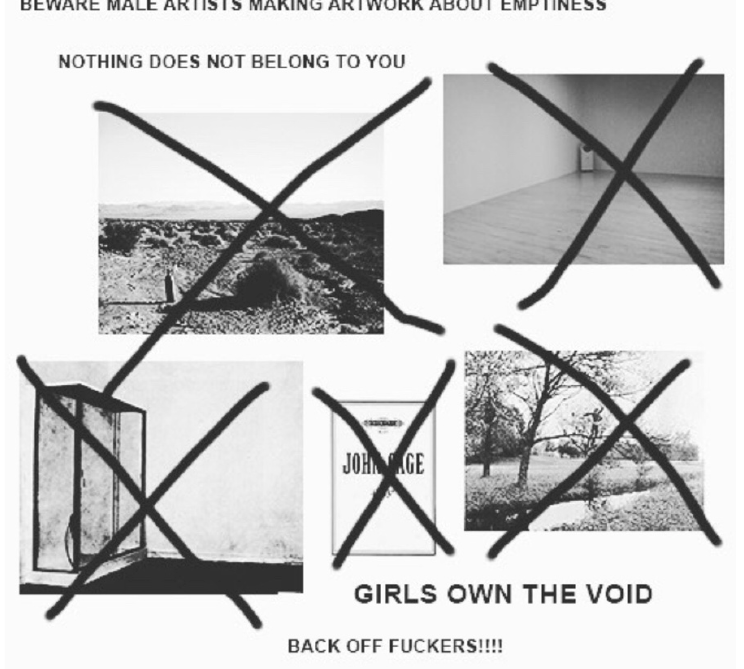
Figure 6. a PSA brought to you by ur local chapter of Female Nothingness, Audrey Woollen Insta- Instagram post, October gram post, October 2015.